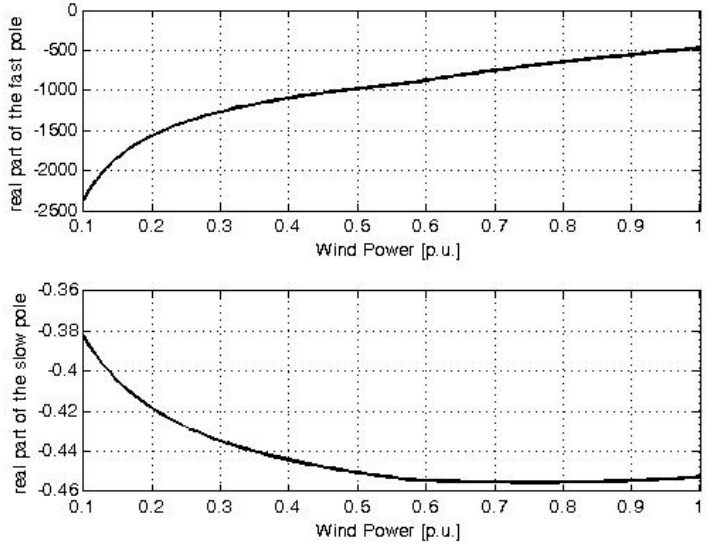
Figure 14. Machine voltage loop poles.